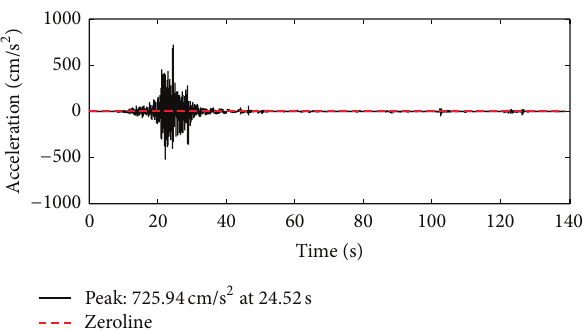
Figure 6: Acceleration time history (NZGDLC.raw, UP, ratl = 1.12, ratr = 1.71).